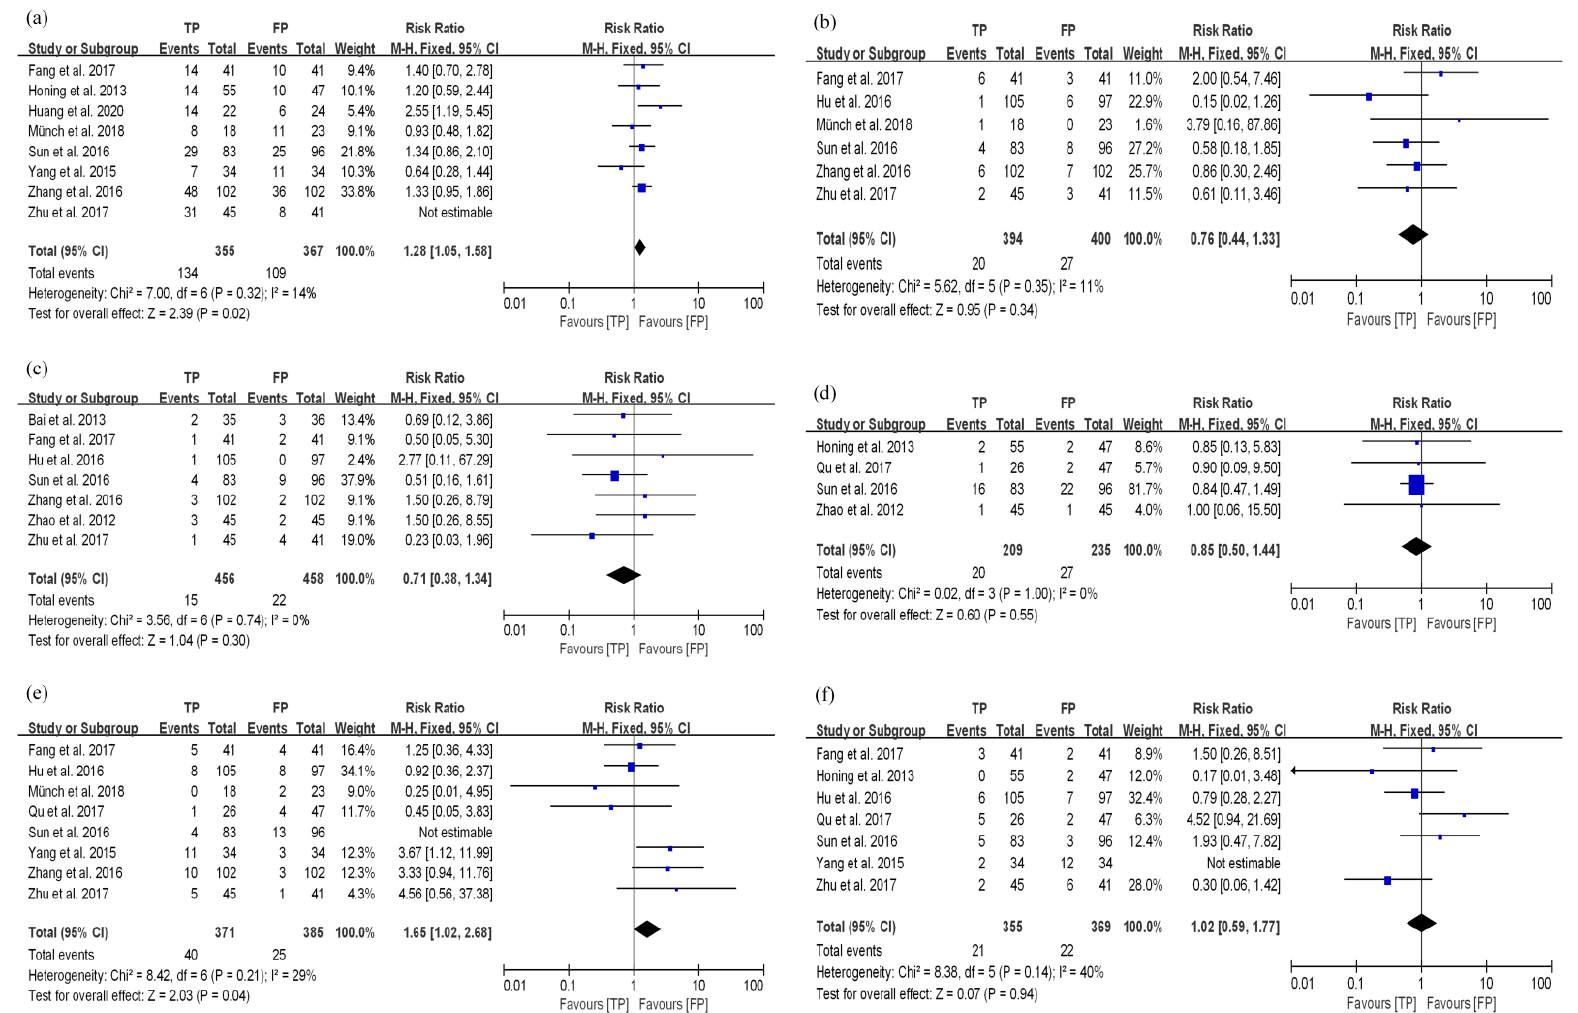
Figure 6. The related toxicity of TP and FP in EC patients treated with dCRT. ( a ) leucopenia; ( b ) anemia; ( c ) pneumonia; ( d ) mucositis; ( e ) thrombocytopenia; ( f )